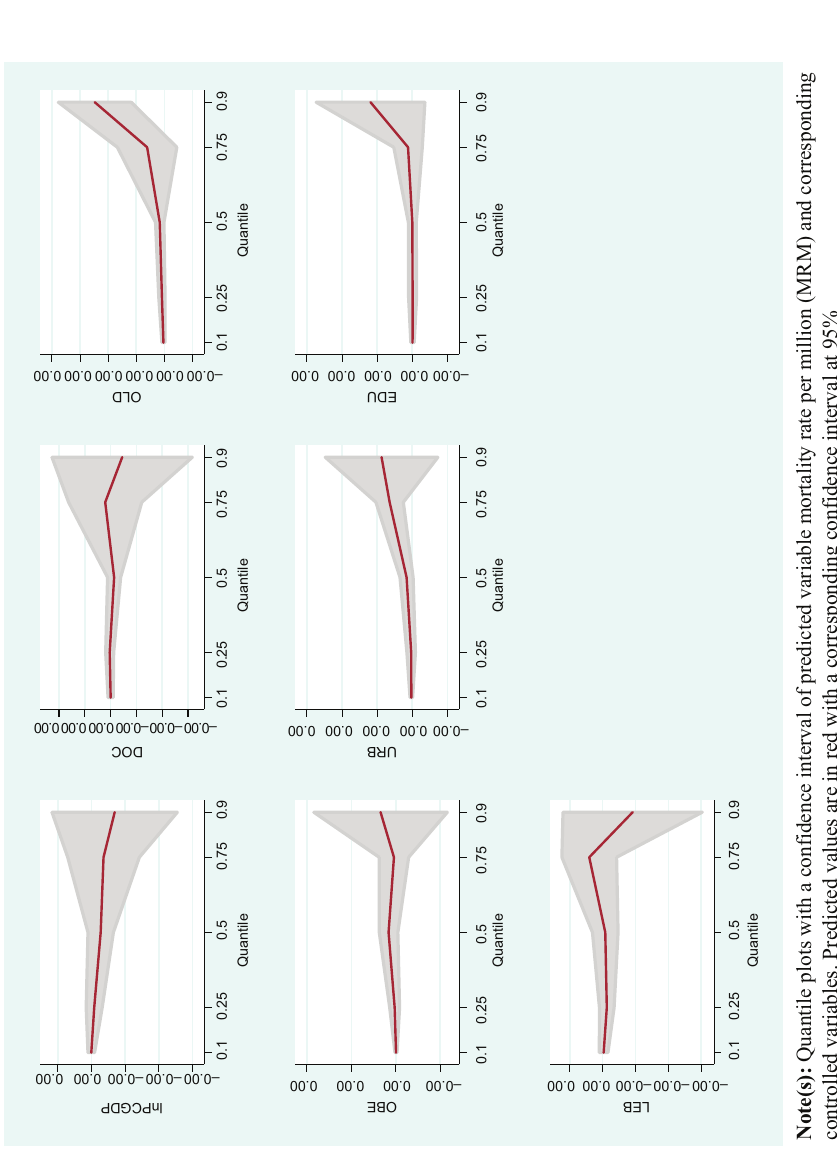
Figure 1. Quantile regression